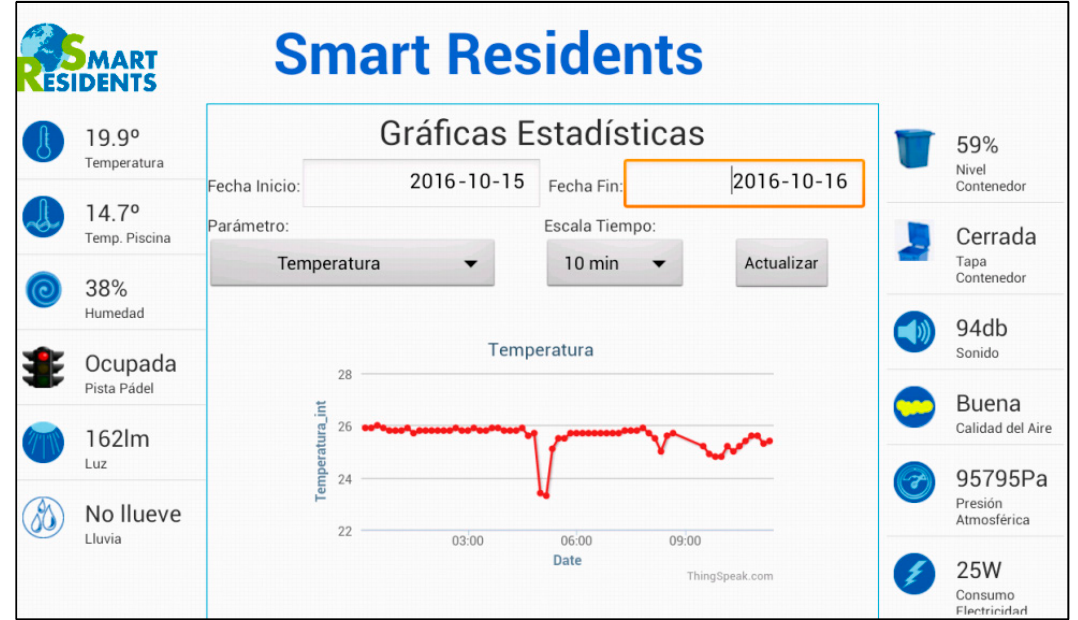
Figure 8. SmartResidents interface for a specific sensor (Temperature).